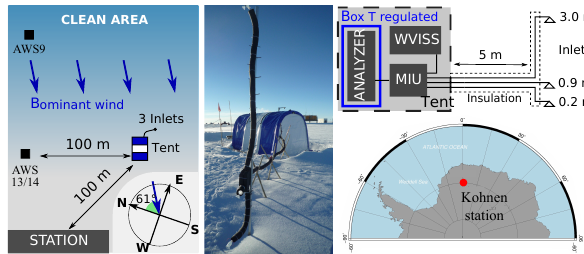
Figure 1. Location of Kohnen station in Antarctica (bottom right panel). Location of the two automatic weather stations (AWS, left panel) and location of the measurement tent connected to the three inlets (central panel). The right schematic presents the setup with the three inlets: the multiport (MIU), the Water Vapor Isotope Stan- dard Source (WVISS) and the analyzer measuring the humidity mixing ratio q and isotopes δ D and δ 18 O in the